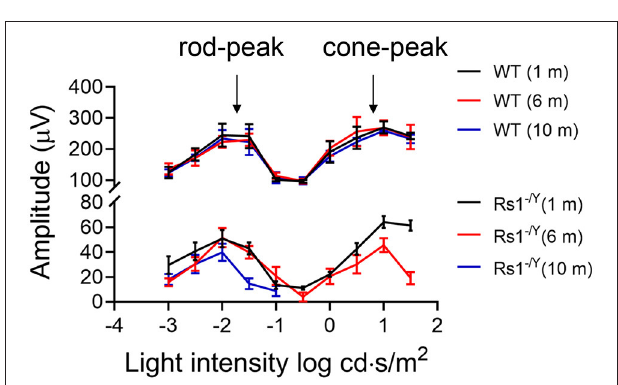
FIGURE 7 | Dark-adapted 10-Hz flicker ERG response amplitude-intensity profiles ( n = 3 at each age